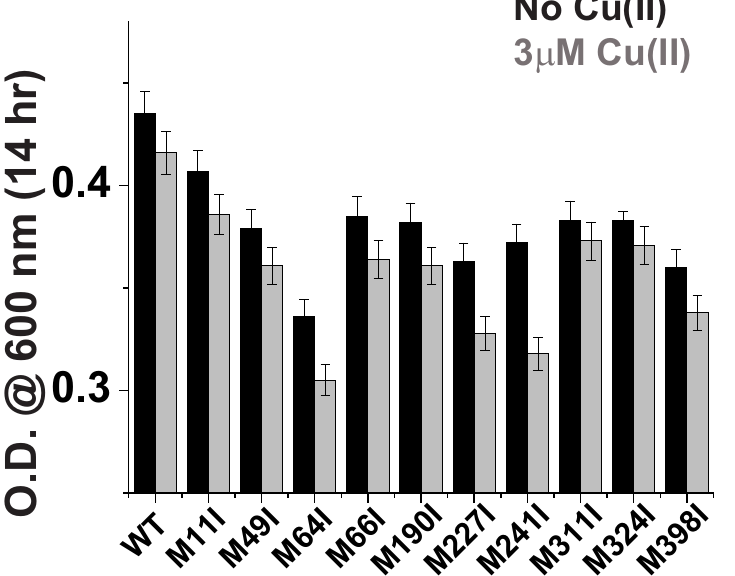
Fig 2. Cell growth rates for various CusB clones in the absence (black) and presence (gray) of 3 μ M Cu(II) after 14